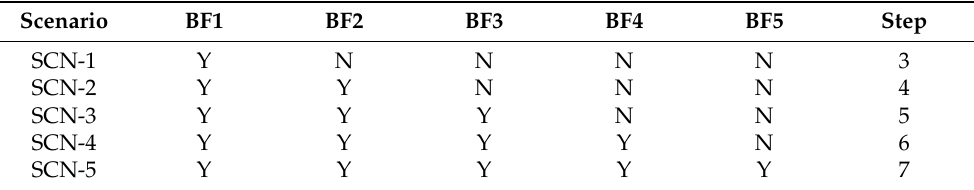
Table 2. Five different backfilling scenarios.